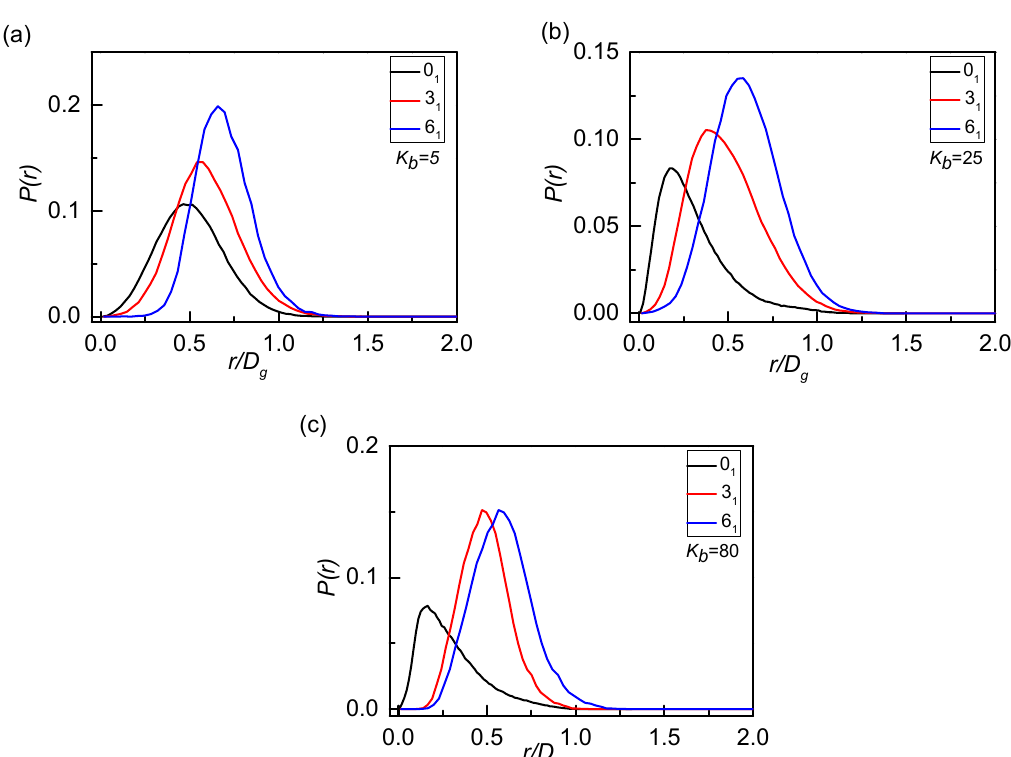
Figure 4. Probability density distributions P ( r ) of penetrated rings for different bending energies K b corresponding to the case of ( a ) flexible rings, ( b )semi-flexible rings, and ( c ) rigid rings with three knot types. P ( r ) denotes the probability distribution for the centers of mass between two penetrated rings. The r is rescaled by D g thus the normalization condition satisfies (cid:1516) 𝑃(𝑟)𝑑𝑟 = D g .